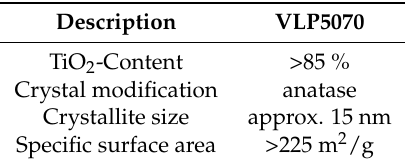
Table 1. Physical characteristics of the VLP5070 (Kronos) TiO 2